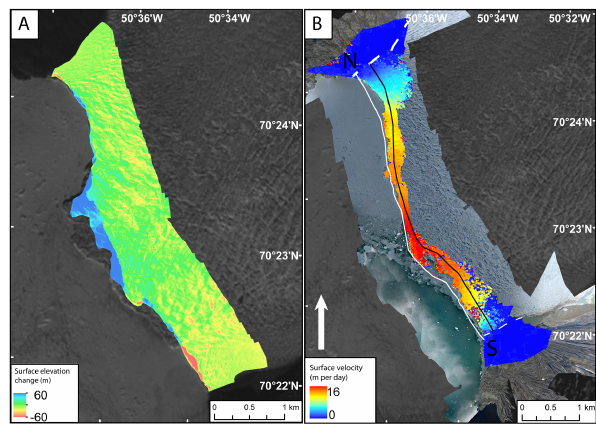
Figure 4. (a) Surface elevation changes between 2 July and 23 Au- gust. An average thinning of 0.12md − 1 was estimated for the sur- veyed area. (b) The ice-flow speed structure of the terminus of Store Glacier between 1 and 2 July 2013. The centre of the glacier flows at approximately 16md − 1 whilst the margins flow less than 5md − 1 . Dotted white lines show the lateral margins of the glacier. The black line represents the locations of the horizontal velocity and surface elevation values that were used to estimate ice flux. The white line represents the location of the depth values used to estimate ice flux. The cross section of the calving front derived from these profiles is displayed in (a)